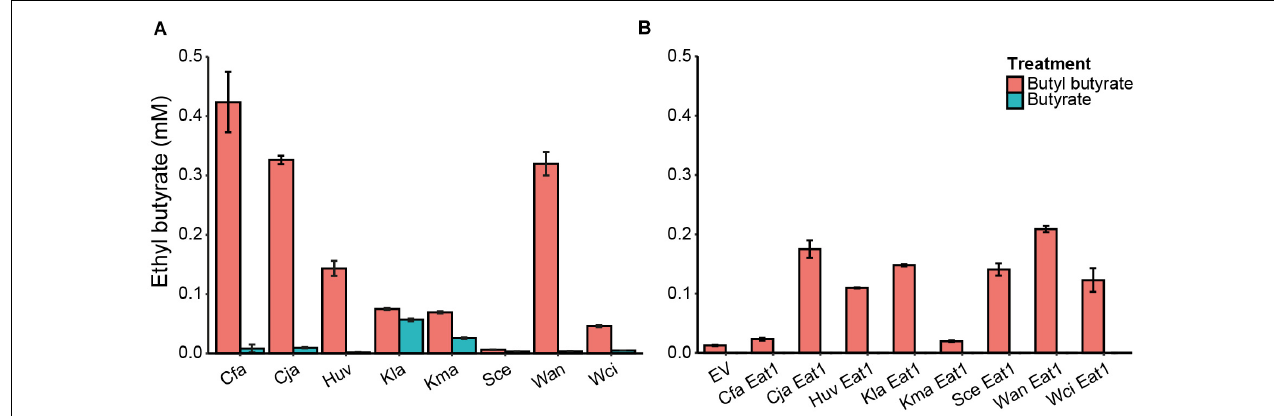
FIGURE 4 | In vivo alcoholysis in wild type yeasts or in engineered S. cerevisiae . (A) In vivo alcoholysis by WT yeasts grown in the presence of 5 mM butyl butyrate (red bars) or 5 mM butyrate (blue bars) for 48 h. n = 3. (B) Screening of different Eat1 homologs for their capacity for alcoholysis when expressed in S. cerevisiae grown for 24 h in the presence of 5 mM butyl butyrate (red bars) or 5 mM butyrate (blue bars). n = 3. EV, empty vector; Cfa, Cyberlindnera fabianii ; Cja, Cyberlindnera jadinii ; Huv, Hanseniaspora uvarum ; Kla, Kluyveromyces lactis ; Kma, Kluyveromyces marxianus ; Sce, Saccharomyces cerevisiae ; Wan, Wickerhamomyces anomalus ; Wci, Wickerhamomyces ciferrii . The error bars indicate standard deviations.